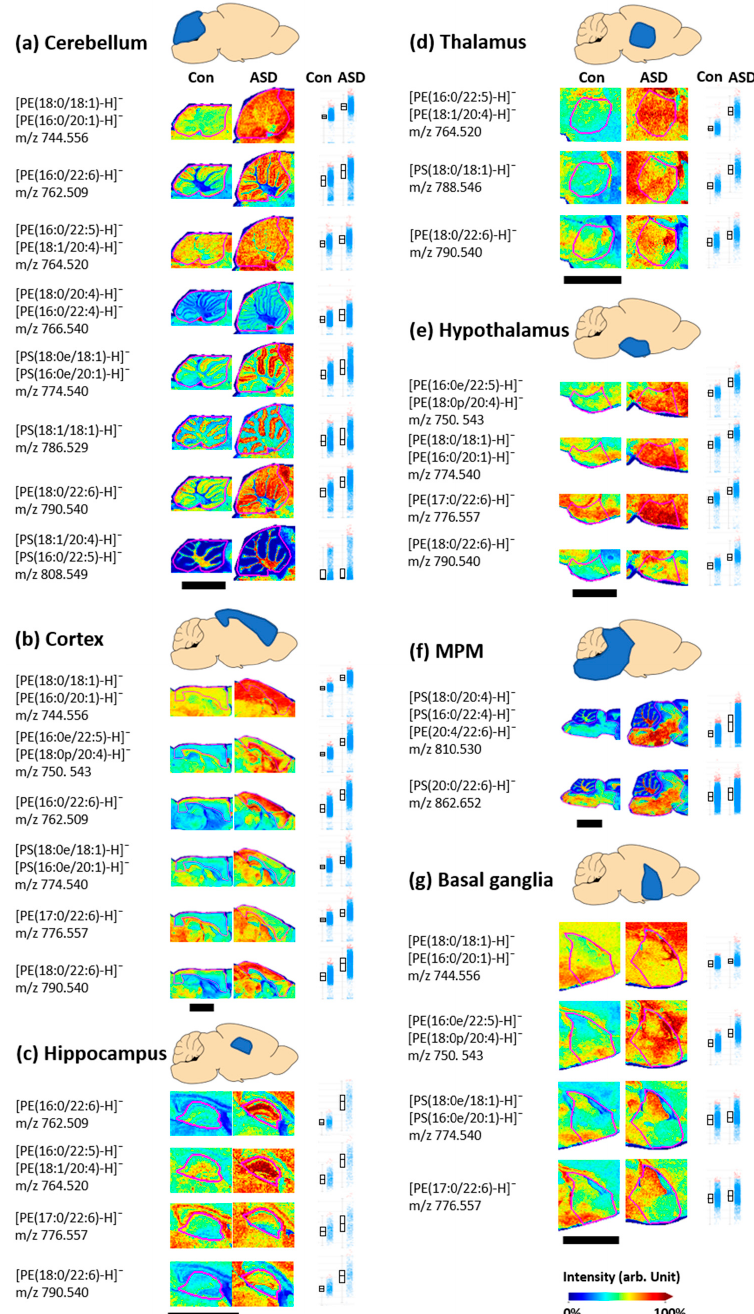
Figure 3. Matrix-assisted laser desorption/ionization mass spectrometry imaging (MALDI-MSI) results and intensity box plots of negatively charged phospholipid ions detected in the control (Con) and valproic acid-induced autism spectrum disorder model (ASD) groups. Comparison of the relative intensity of negatively charged phospholipids was performed in the cerebellum ( a ), cortex ( b ), hippocampus ( c ), thalamus ( d ), hypothalamus ( e ), MPM ( f ), and basal ganglia ( g ), respectively. The magenta lines shown on the MALDI-MSI results indicate each part of the brain tissue, and the scale bars are 3 mm. In the intensity box plots, the y -axis represents the total ion count normalized intensity, and the horizontal line of the box part represents the median intensity defined so that the number of spectra with low and high values are the same. The spectra for which the intensities of a specific m / z value are between the lower and upper quantiles are shown by blue dots. Spectra with intensities outside of these intensity intervals are shown by red